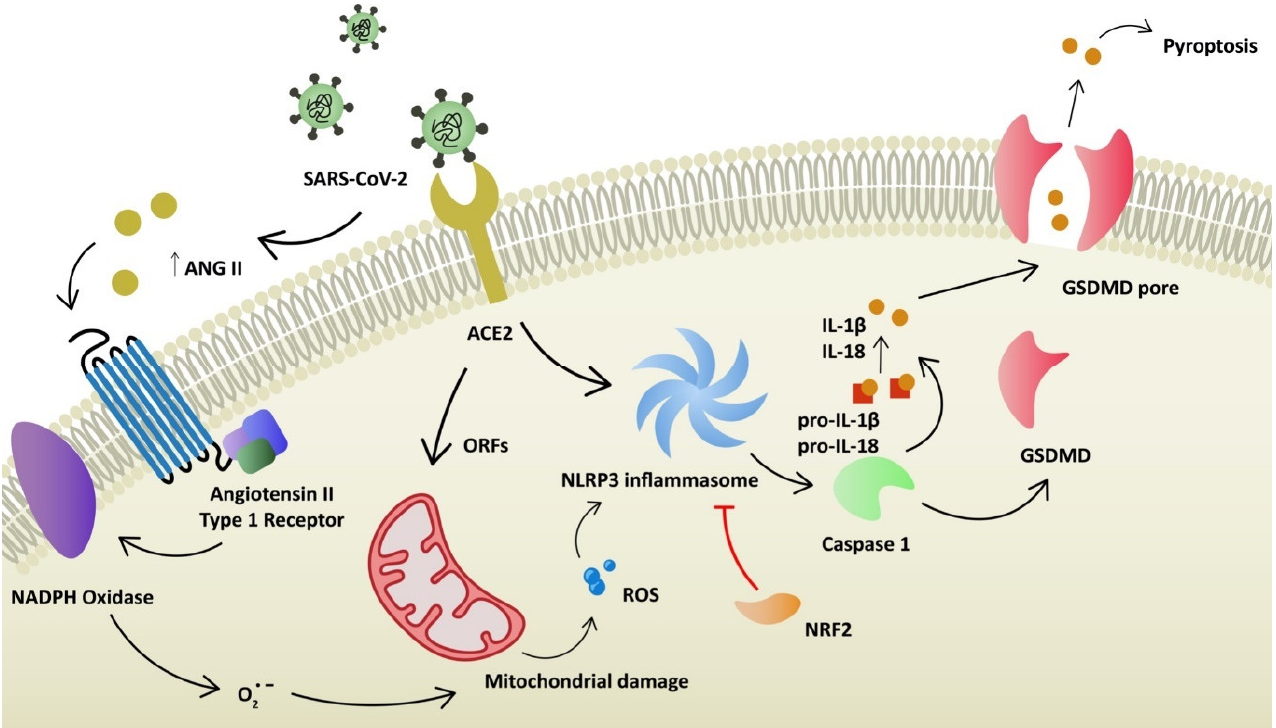
Figure 2. Hypothesized intracellular processes after infection of SARS-CoV-2, leading to mitochondrial damage, production of reactive oxygen species and pro-inflammatory state of the cell: ACE2—angiotensin convertase enzyme 2; ANG II—angiotensin II; ORF—open reading frame; ROS—reactive oxygen species, GSDMD—gasdermin D.